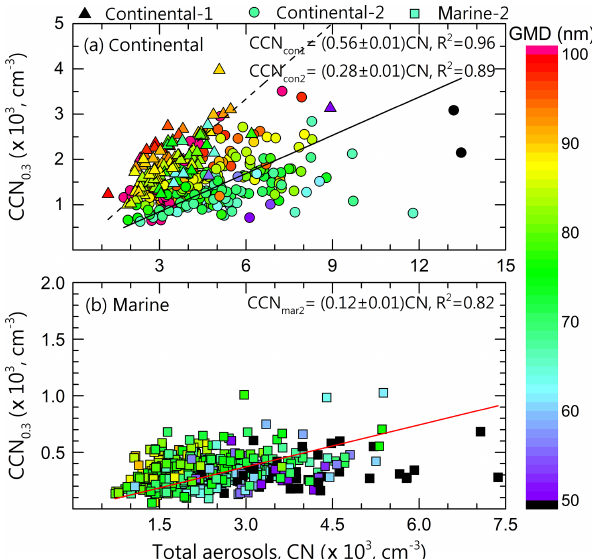
Figure 7. Association between CCN (at 0.3% SS) and CN concen- trations segregated to (a) continental and (b) marine conditions. The color of the scatter indicates the concurrent geometrical mean diam- eter of the aerosol system. The least-square linear fit is also shown along with the fit